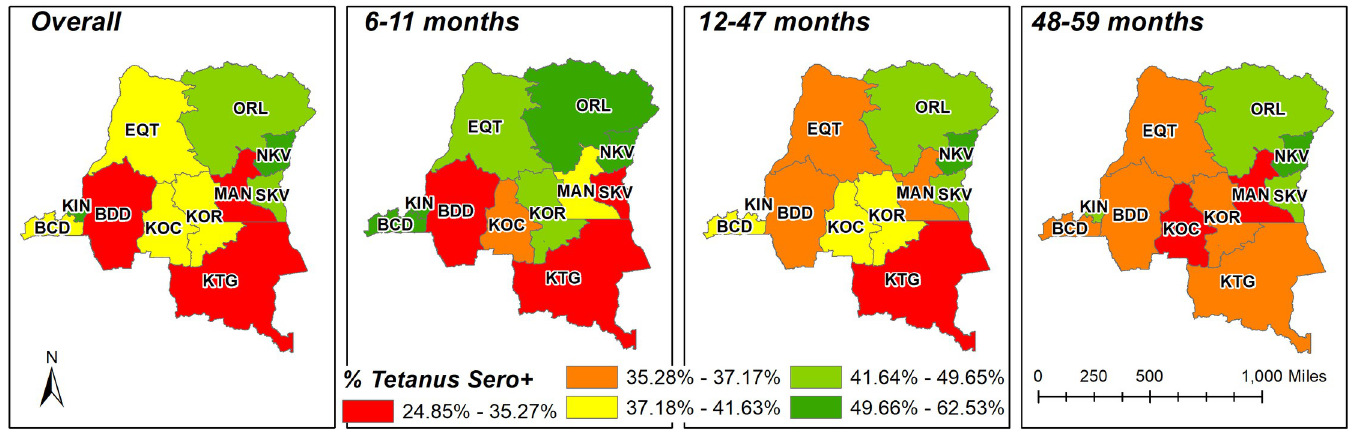
Fig 3. Tetanus seroprotection by province and age among children 6–59 months old in the EDS-RDC II.